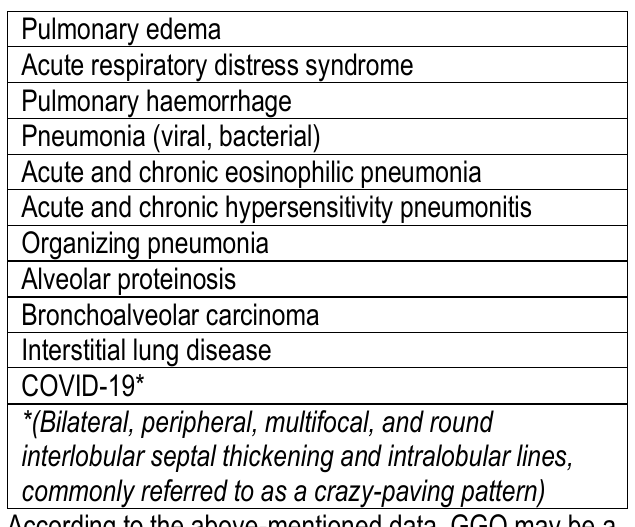
Table 1. Common causes of ground glass opacities and features of COVID-19 related ground glass opacities [5,